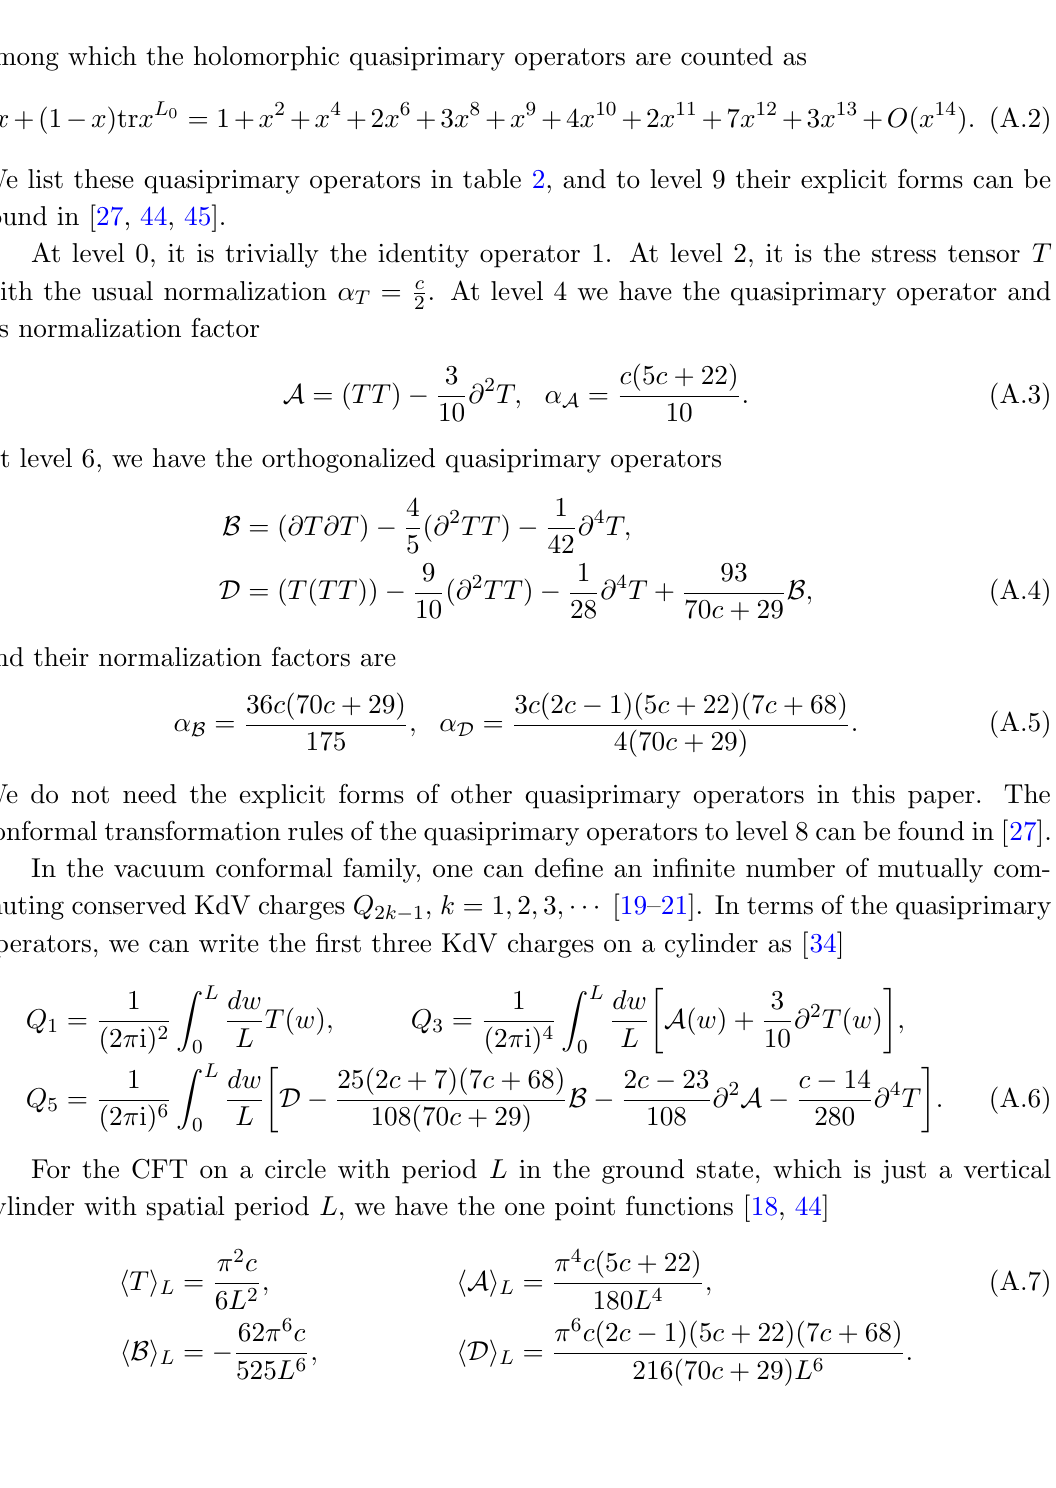
Table 2 . Holomorphic quasiprimary operators in the vacuum conformal family. The ranges in which the m ’s take values can be read in (A.2). For examples, at level 10 we have m = 1 ; 2 ; 3 ; 4, and at level 11 we have m = 1 ;